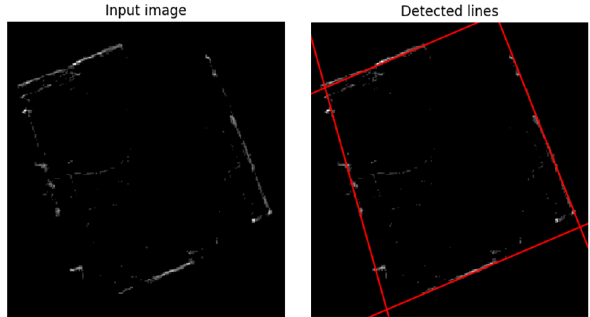
Figure 5. Derived heat map of the room used to extract the most prominent lines using Hough transform algorithm.